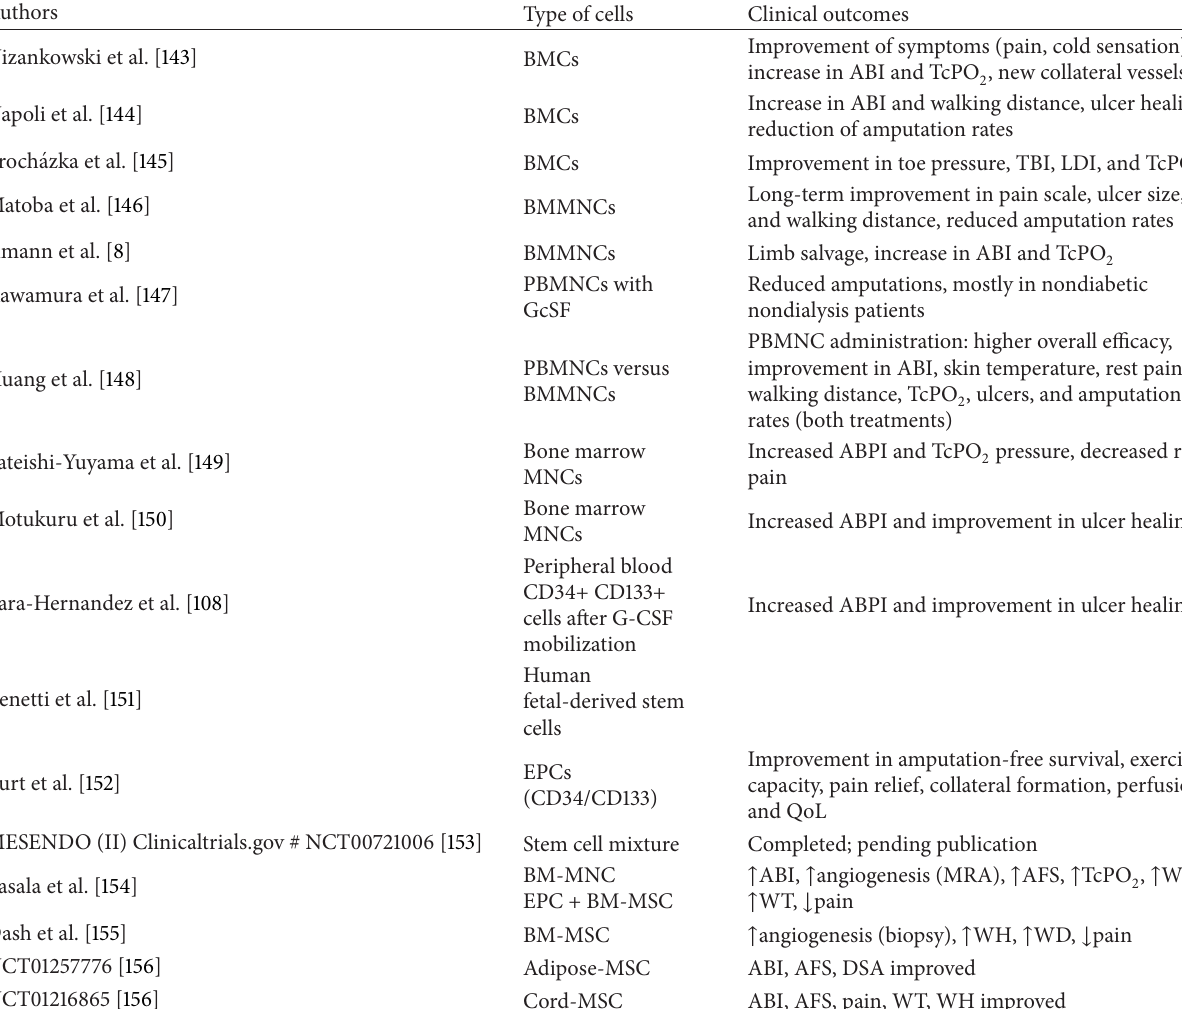
Table 2: Clinical trials using stem cells for treatment of critical limb